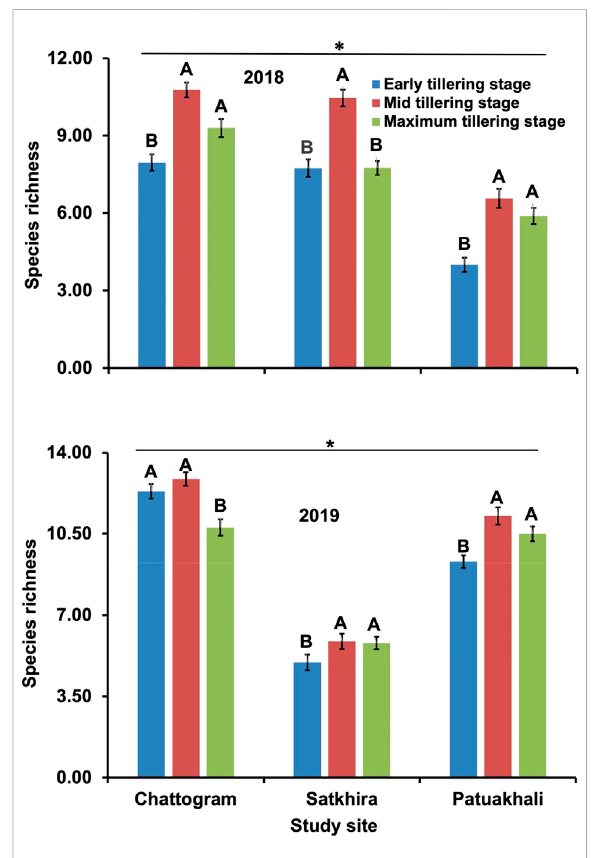
FIGURE 1 Comparative graphical representation of species richness in three geographic locations. Diversity measured at early tillering stage, mid tillering stage and maximum tillering stage of 2018 (upper fi gure) and at early, mid, maximum tillering stage values, which increased in 2019 (lower fi gure). This is remarkably so in Patuakhali ’ s early tillering stage while Satkhira looks same (despite the maximum tillering stage having increased). In Chattogram, the mid tillering stage has decreased in 2019 but, overall,themeanvaluesofdiversitytendtobeincreasedi.e.,mixed nature of land